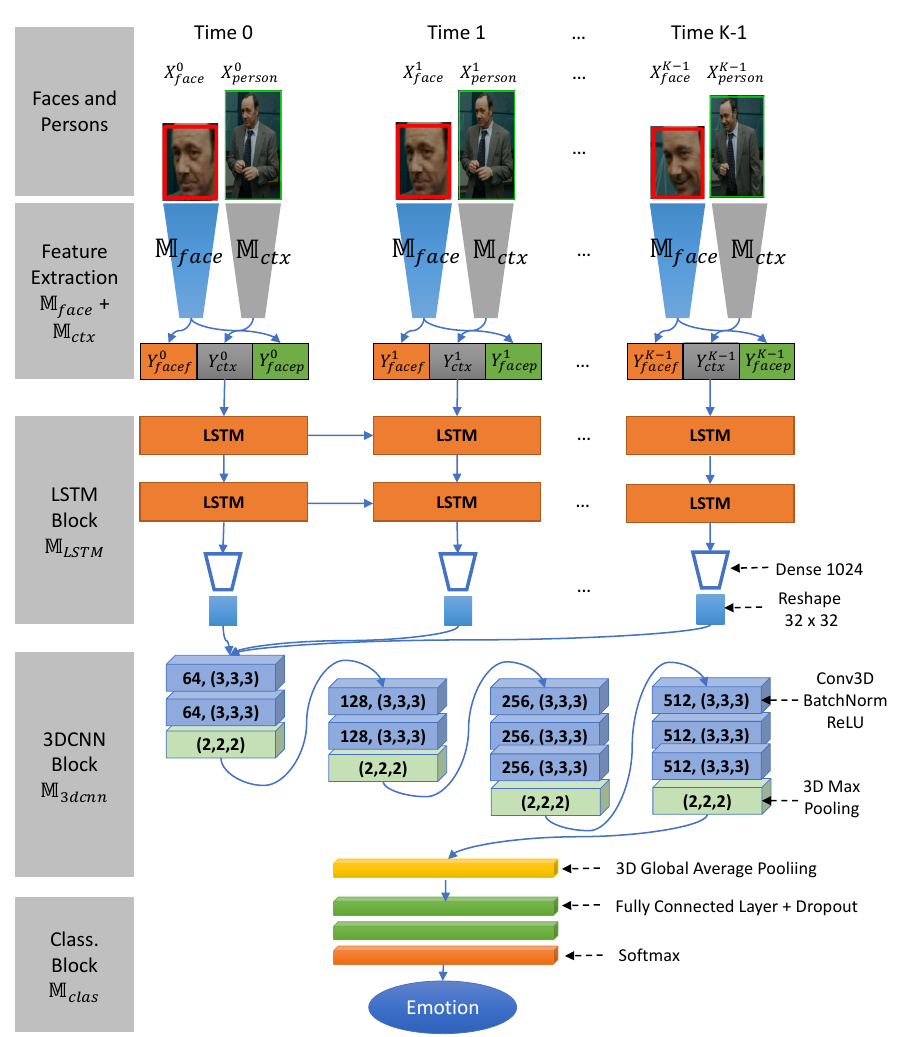
Figure 4. Context Spatio-Temporal LSTM-3DCNN